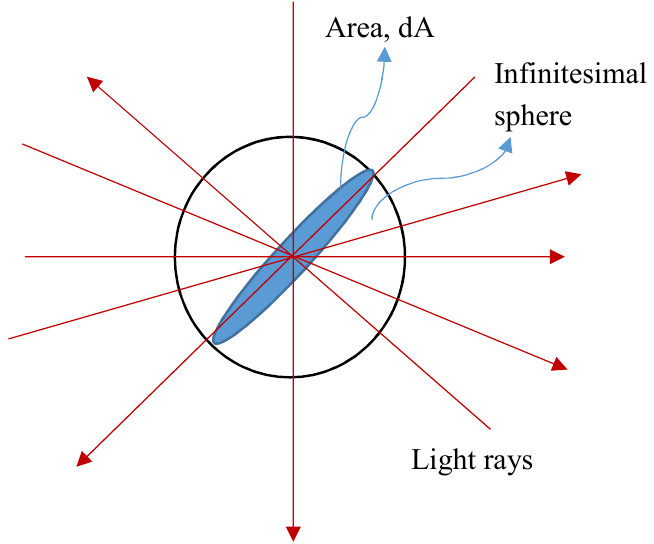
Figure 3. Graphical interpretation of fluence. Total cumulative radiant energy incident on the small sphere from all directions per unit cross-section area of the sphere.